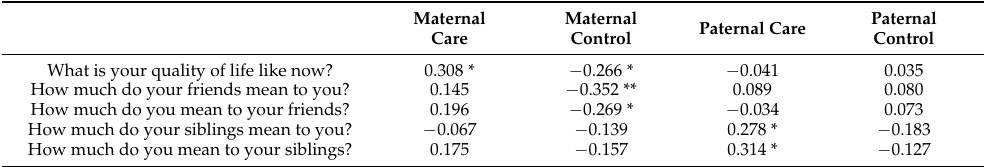
Table 5. Correlation coefficients (Pearson r) between Adolescent Relationship Scale and mater- nal and paternal care and control in the First Experimental Study of Transference Interference-In Teenagers (FEST-IT). Maternal Maternal Paternal Care Control Paternal Care Control What is your quality of life like now? 0.308 * − 0.266 * − 0.041 0.035 How much do your friends mean to you? 0.145 − 0.352 ** 0.089 0.080 How much do you mean to your friends? 0.196 − 0.269 * − 0.034 0.073 How much do your siblings mean to you? − 0.067 − 0.139 0.278 * − 0.183 How much do you mean to your siblings? 0.175 − 0.157 0.314